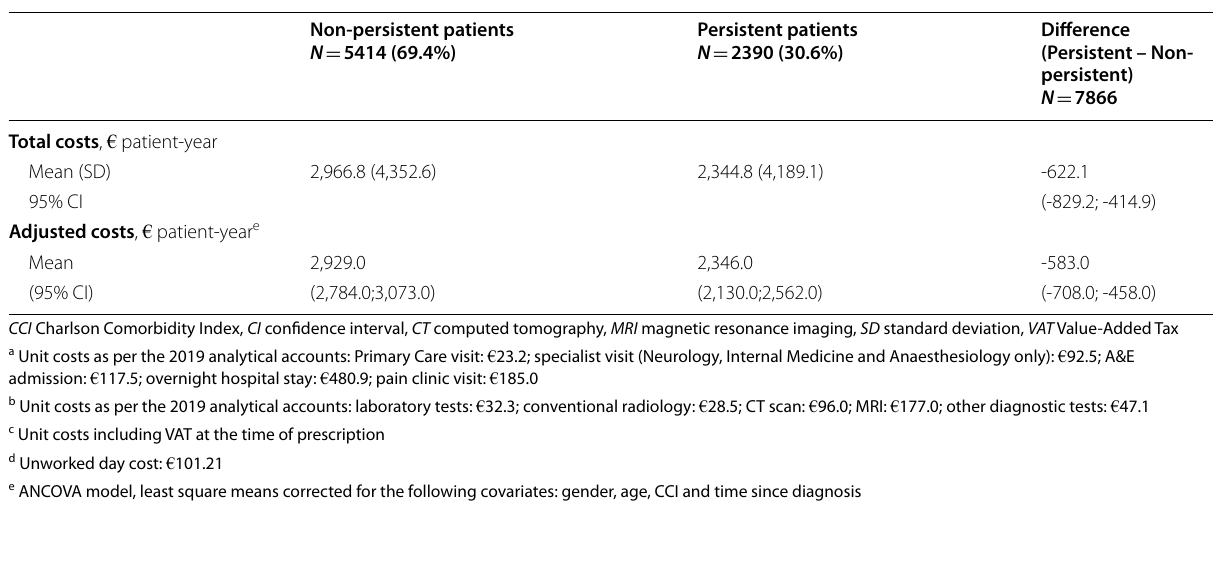
Table 5 Multi‑state model for the migraine preventive treatment: risk of discontinuation and analyzed covariates